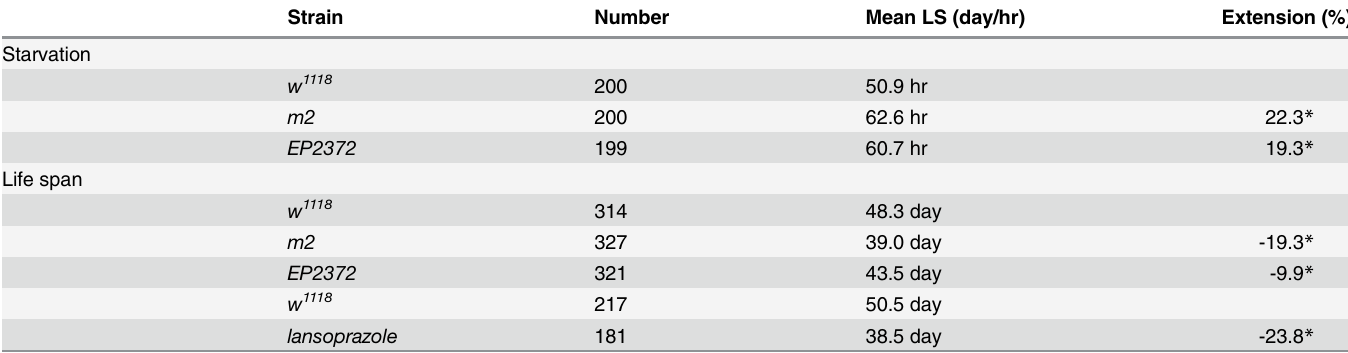
Table 1. The effects of acid suppression on starvation resistance and life span (LS) in Drosophila melanogaster . Strain Number Mean LS (day/hr) Extension (%)